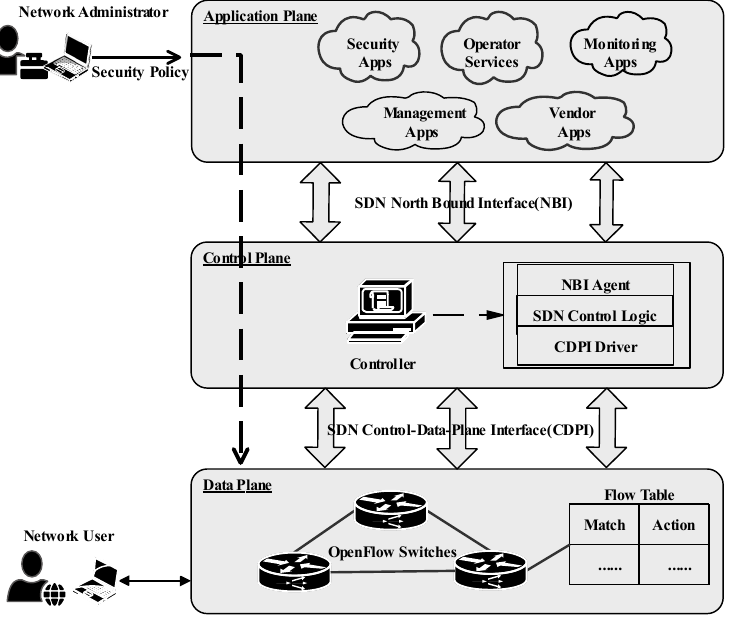
Figure 1. Software-defined networking (SDN) architecture